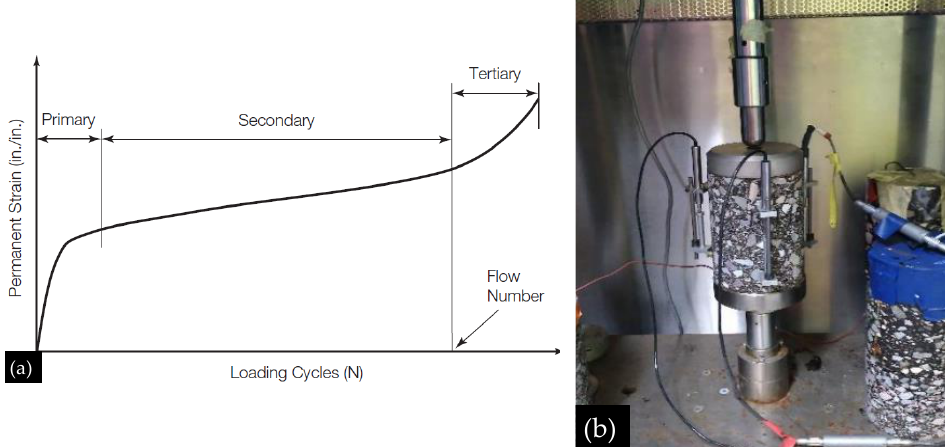
Figure 2. Repeated load permanent deformation test; ( a ) typical relationship between total cumulative plastic strain and number of load cycles and ( b ) specimen set-up.